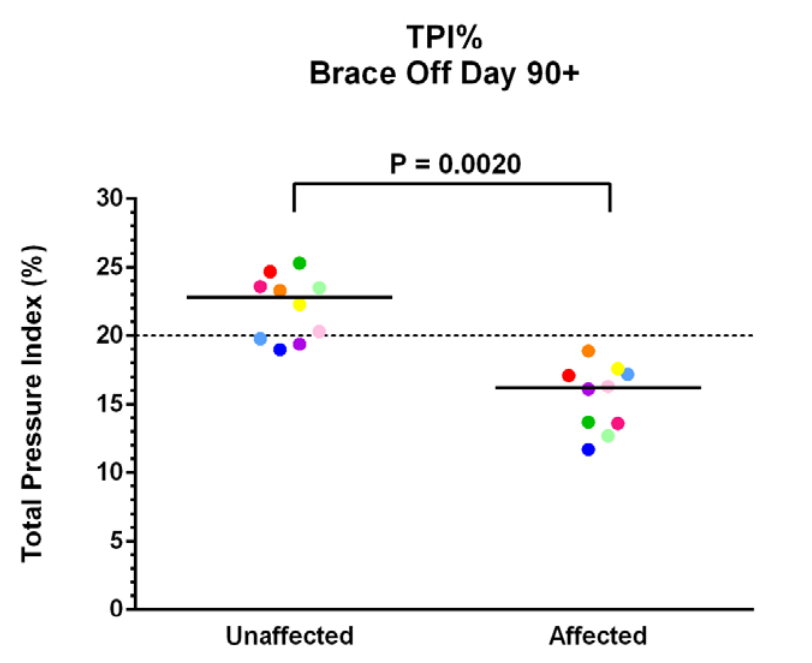
Figure 1: Patient TPI% at day 90+ Without the Orthotic